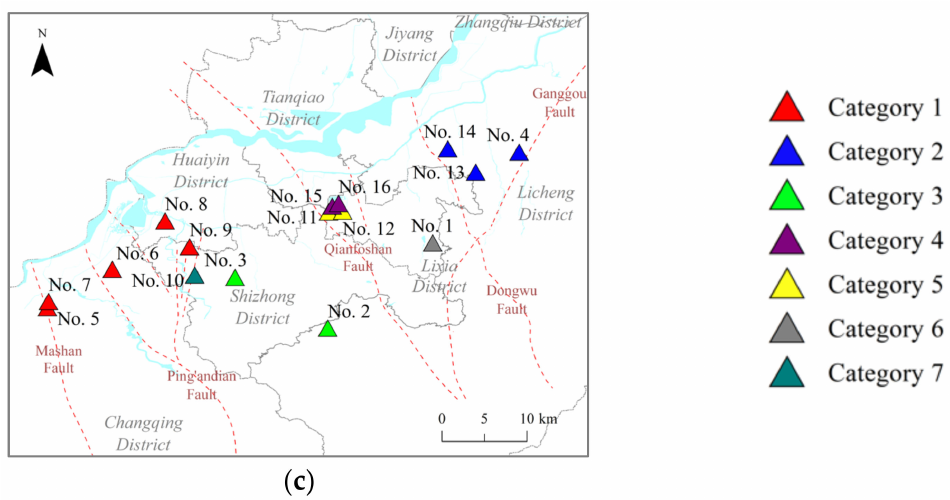
Figure 5. The results of the mixed cluster analysis in which wells were ultimately grouped into seven categories: ( a ) results based on the spatial distance index; ( b ) results based on hydrogeological characteristics; ( c ) final results.